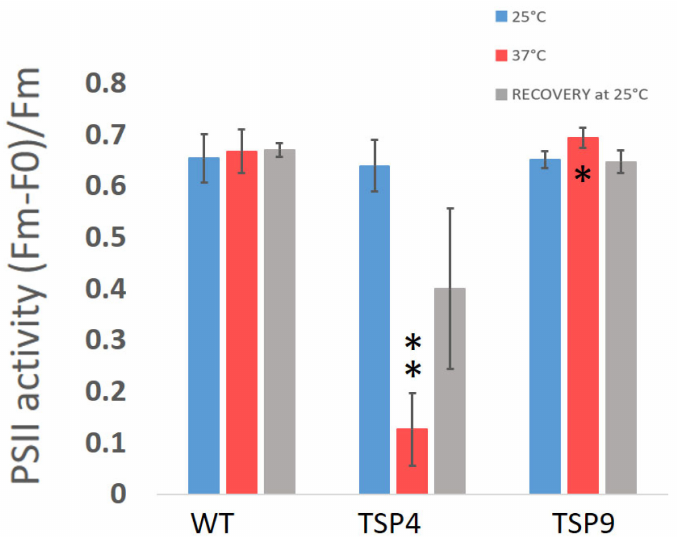
Figure 2. Average ratio of the maximum quantum efficiency of photosystem II (PSII) in the Chlamy- domonas reinhardtii wild type (WT), TSP4, and TSP9 strains at three temperature conditions. Graphs were produced using Excel. Statistical analysis was performed using Graph Pad. The data represent the mean ± standard deviation of six to seven independent experiments. The significance level by an unpaired t -test for “TSP4 vs. WT” and “TSP9 vs. WT” at 37 ◦ C is indicated as follows: no sign means p > 0.01, * means p < 0.01 and ** means p <